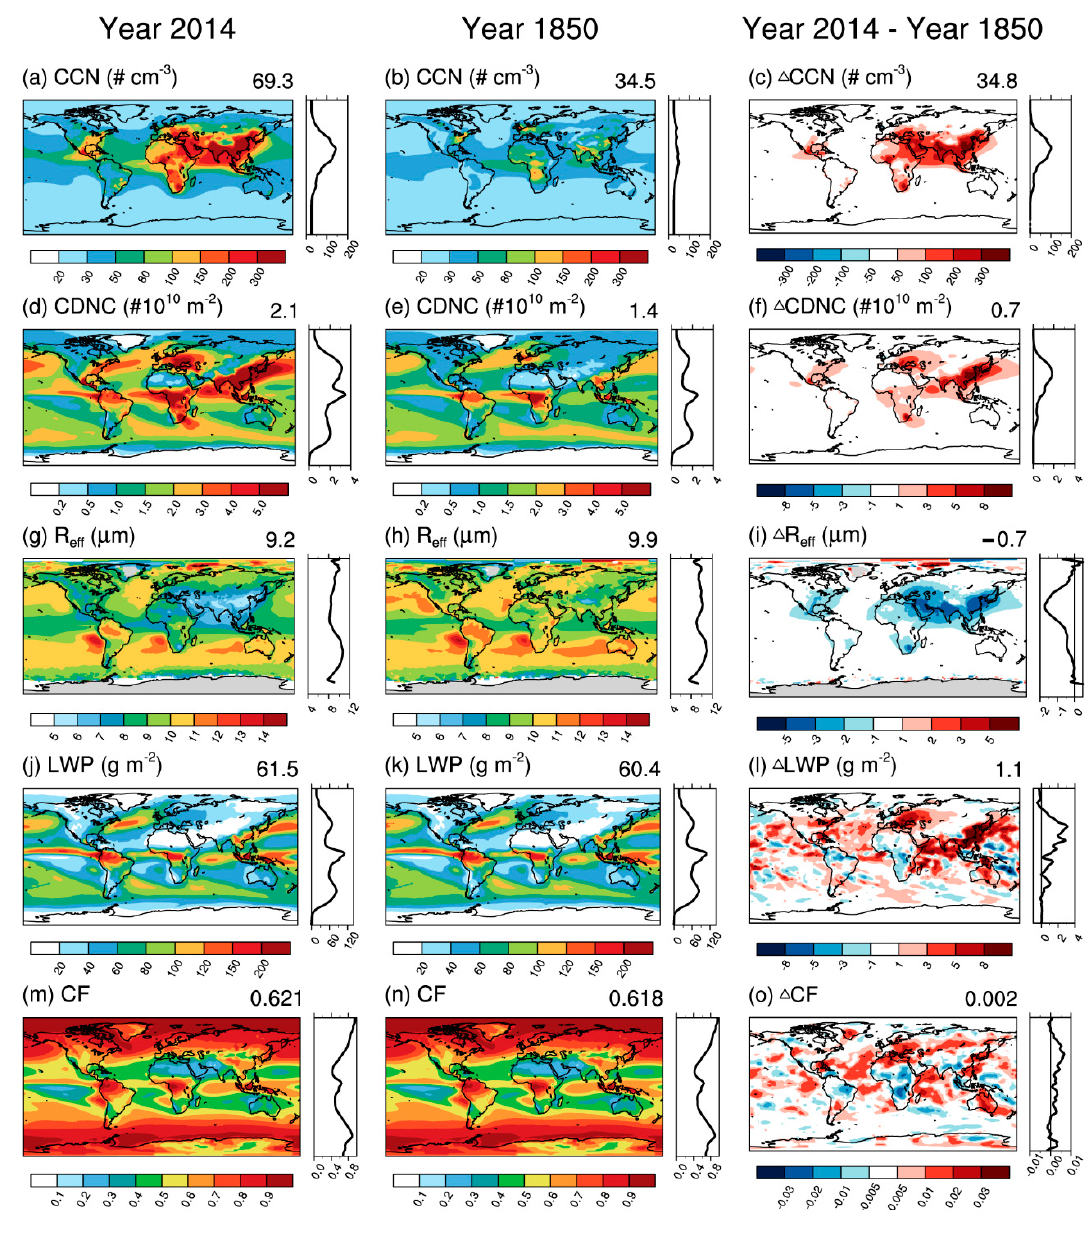
Figure 3. The modelled annual mean cloud physics properties in the year 2014 (left), the year 1850 (middle), and the years 2014–1850 (right). The zonal means plot is located in the right of each subplot. The global mean value is shown the top right corner of each map. The first row ( a – c ) is the cloud condensation nuclei (CCN) number concentration at a fixed 0.1% supersaturation at the surface in the model; the second row ( d – f ) is the column-integrated cloud droplet number concentration (CDNC); the third row ( g – i ) is the cloud droplet effective radius at the cloud top above the temperature of 273 K (R eff ); the fourth row ( j – l ) is the cloud liquid water path (LWP); and the last row ( m – o ) is the total cloud fraction (CF).